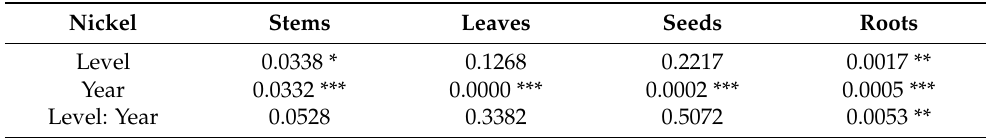
Table 8. Two-way ANOVA of the main factor and interaction for the concentration of nickel in stems, leaves, seeds, and roots during the two years of the experiment (* significance level at p ≤ 0.05, ** significance level at p ≤ 0.005, *** significance level at p ≤